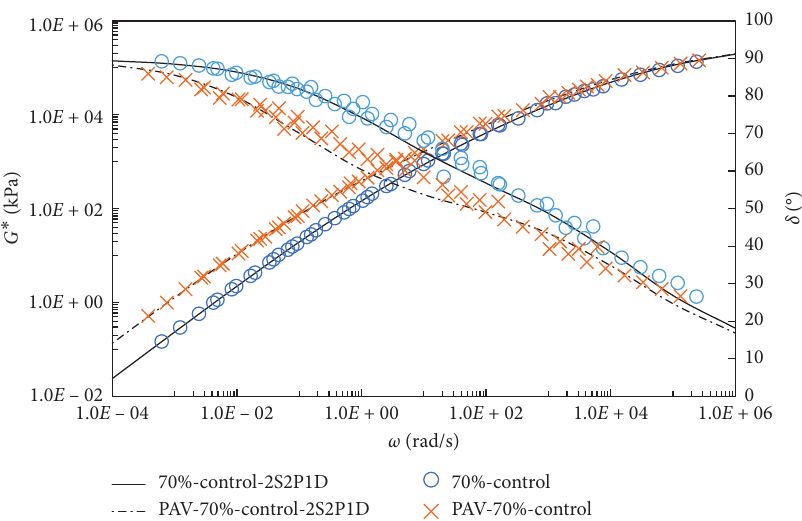
Figure 7: Complex shear modulus and phase angles master curves for control binder containing 70% RAP binder before and after PAV aging.